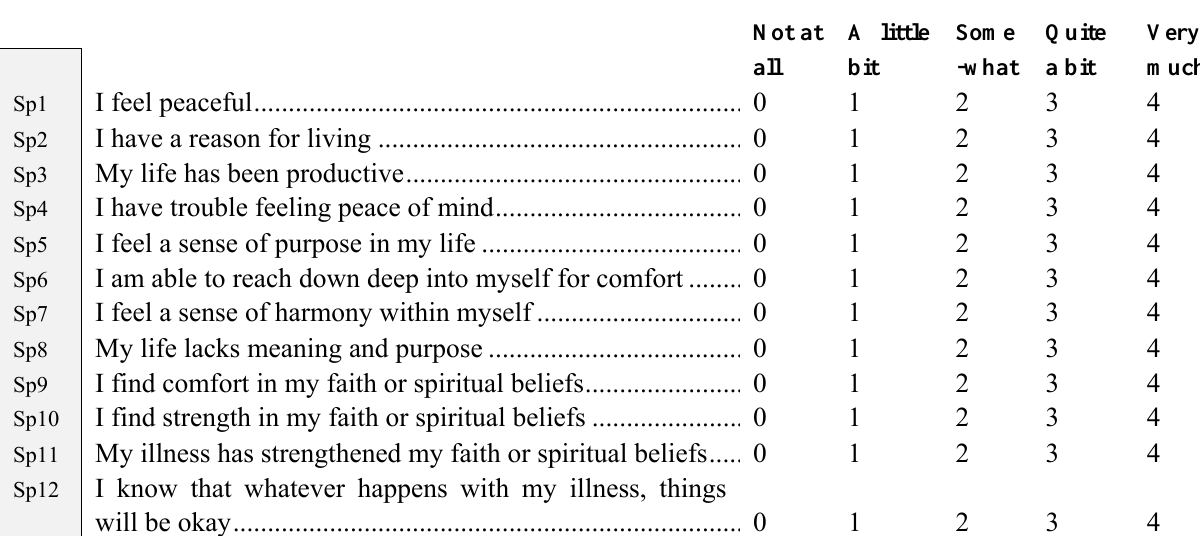
Table 1. FACIT-Sp-12 (version